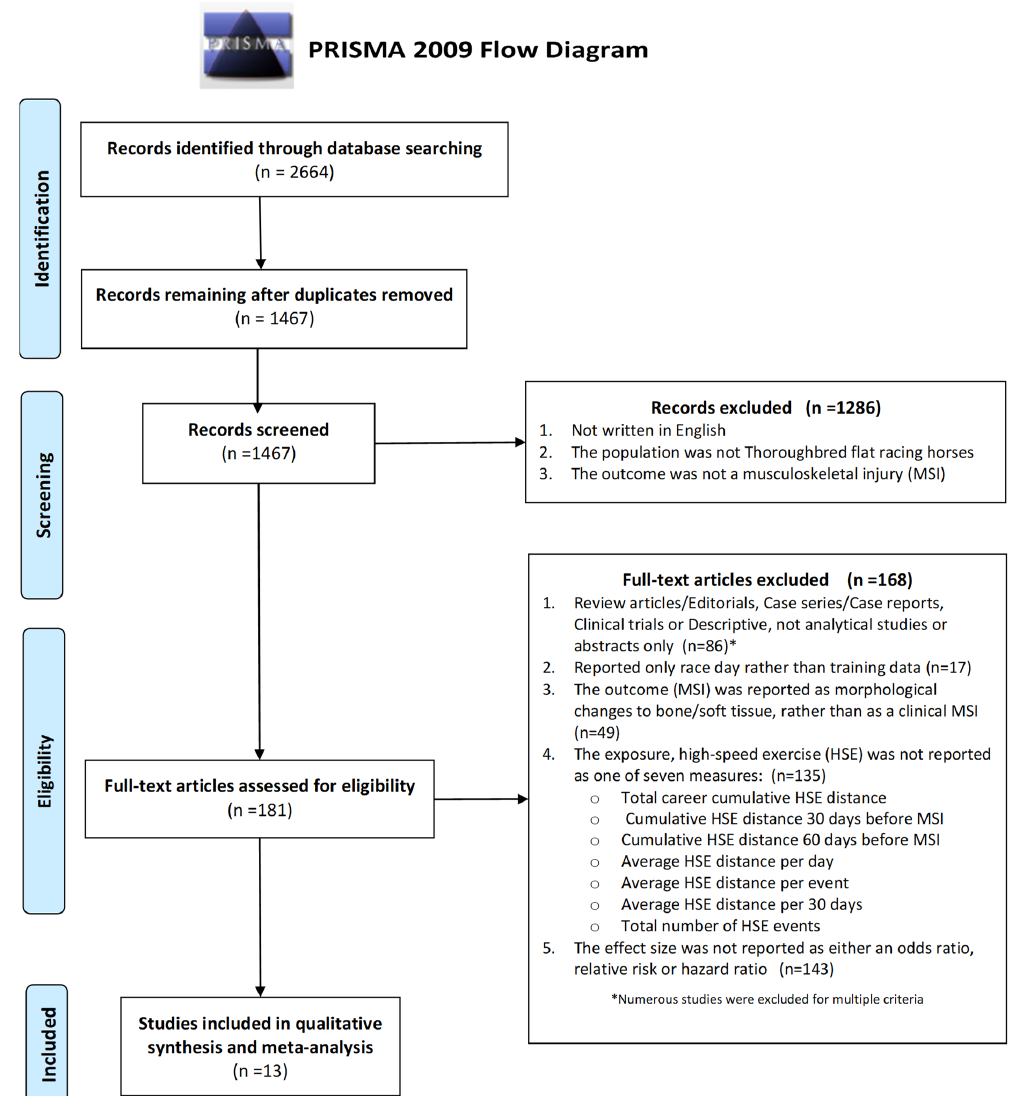
Figure 1. The identification, screening, eligibility, and included articles summarized in a Preferred Reporting Items for Systematic Reviews and Meta-Analyses (PRISMA) flow diagram. A graphical summary of the articles excluded at full text level and the reasons for exclusion are presented in Figure 2.